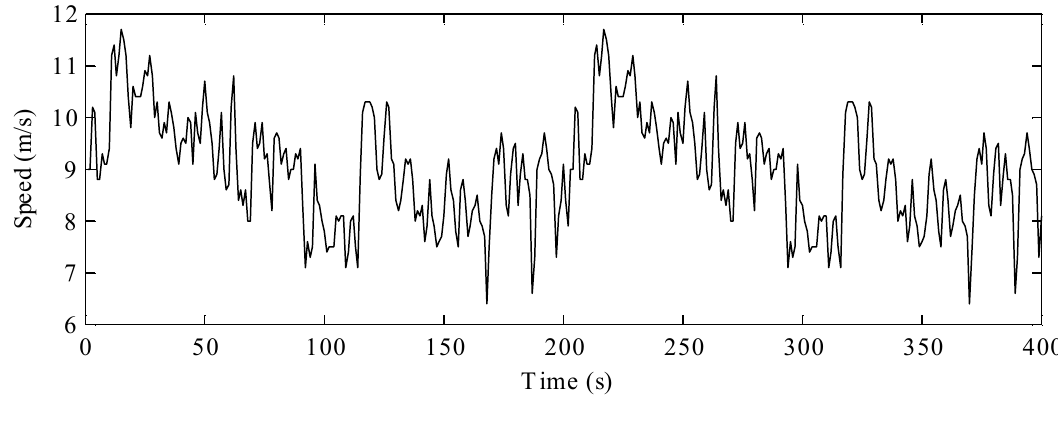
Figure 6. Actual wind speed